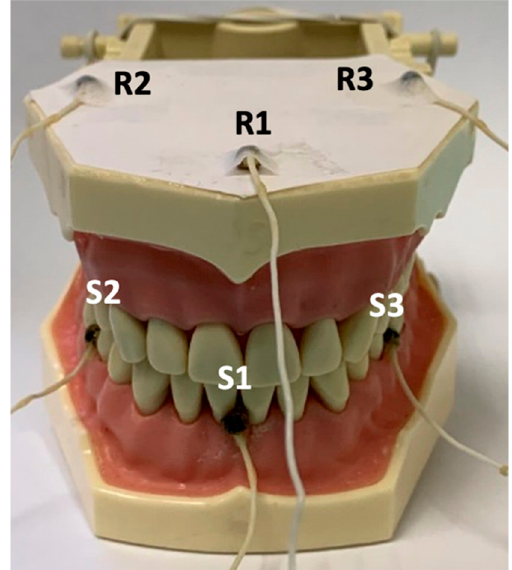
Figure 2. Phantom sensors. Reference sensors R1, R2, and R3. Active sensors S1, S2, and S3.